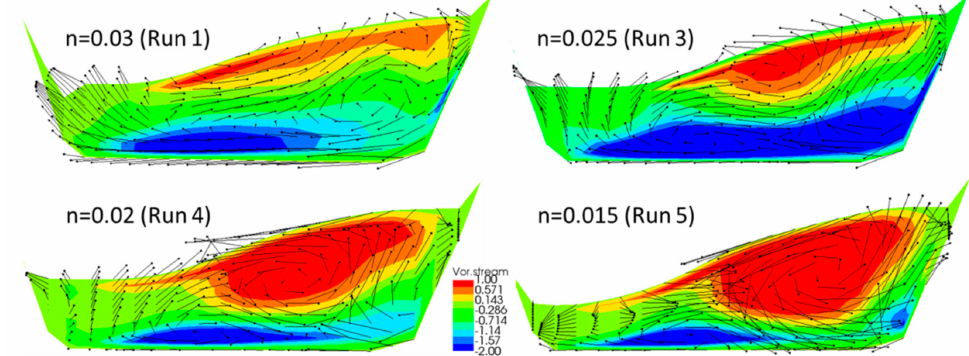
Figure 10. Cross-sectional velocity vectors and color contour of streamwise vorticity along the A-A’ section with different Manning roughness